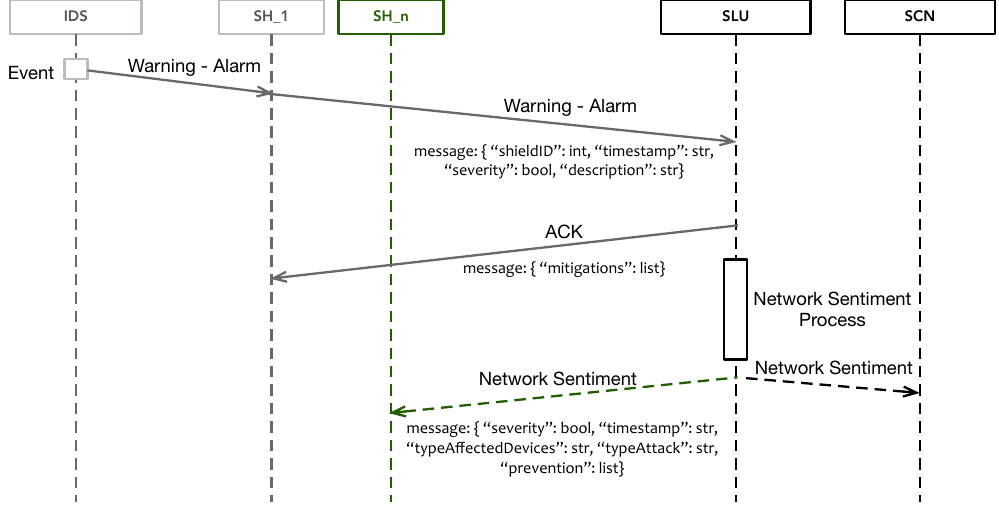
Figure 2. SHIELD blocks